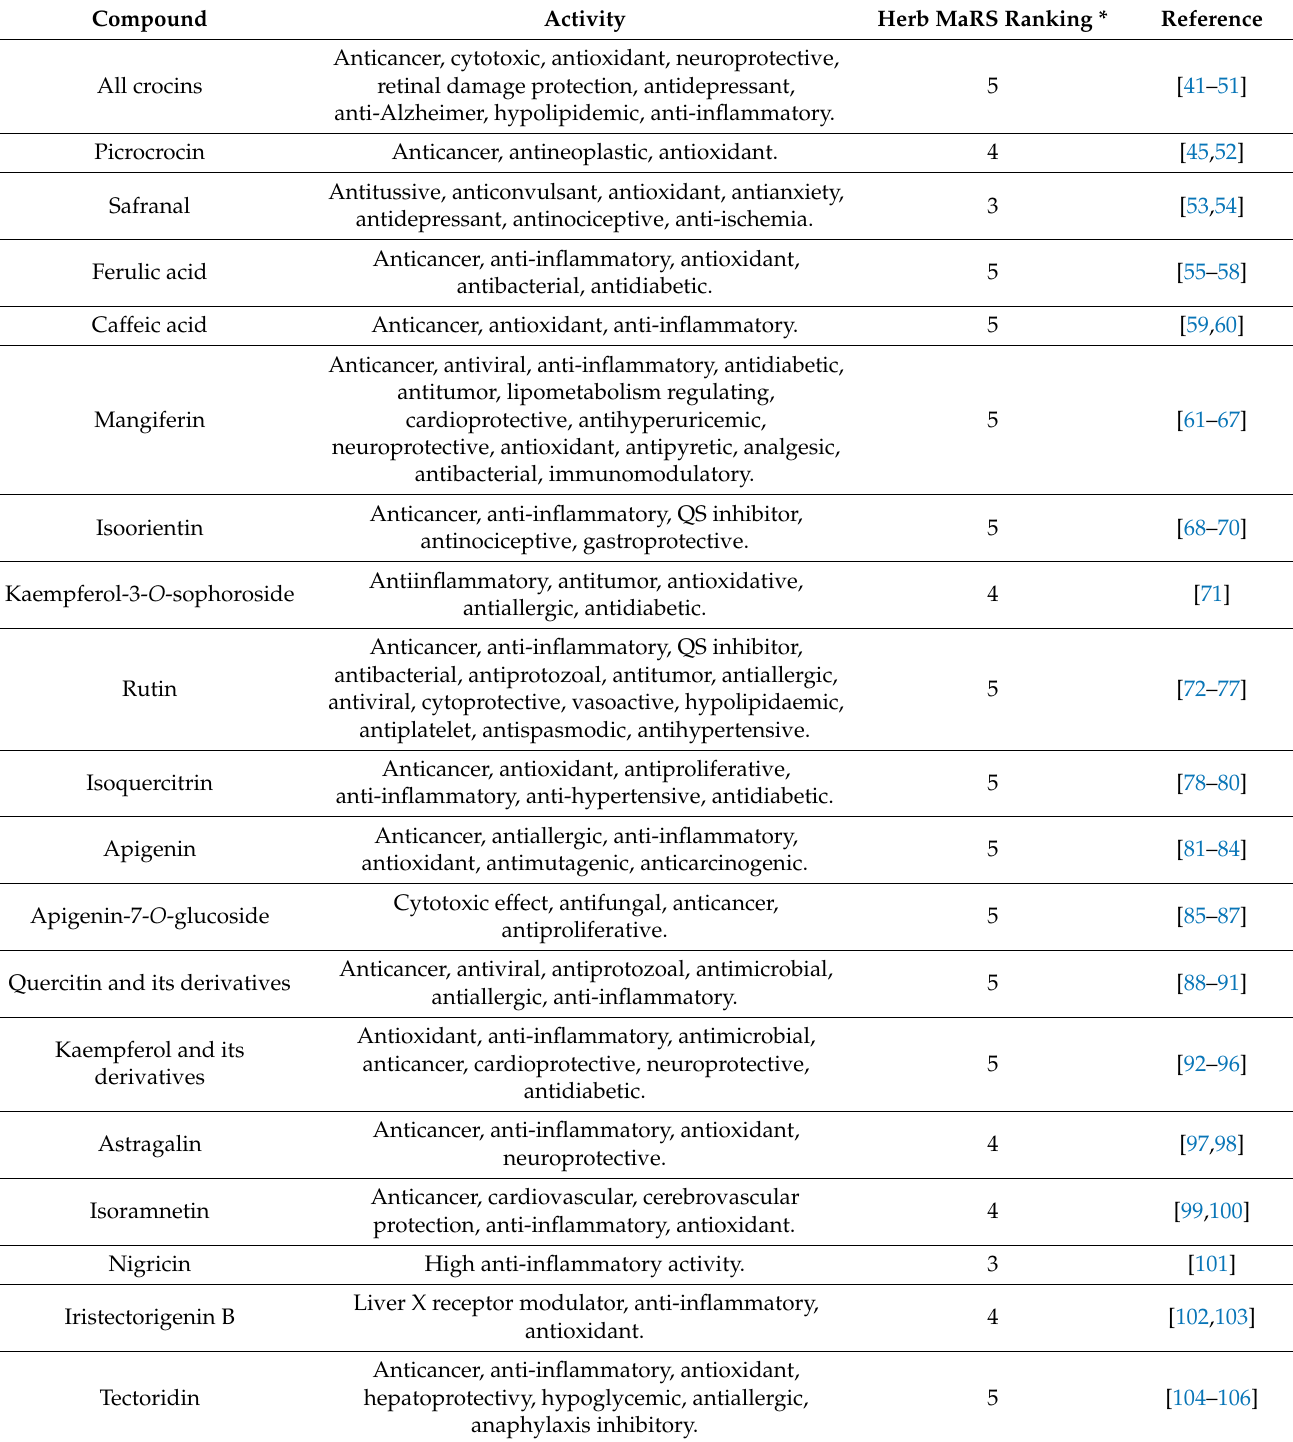
Table 2. Composition of Crocus sativus perianth and relevant Herb MaRS score based on potential anticancer